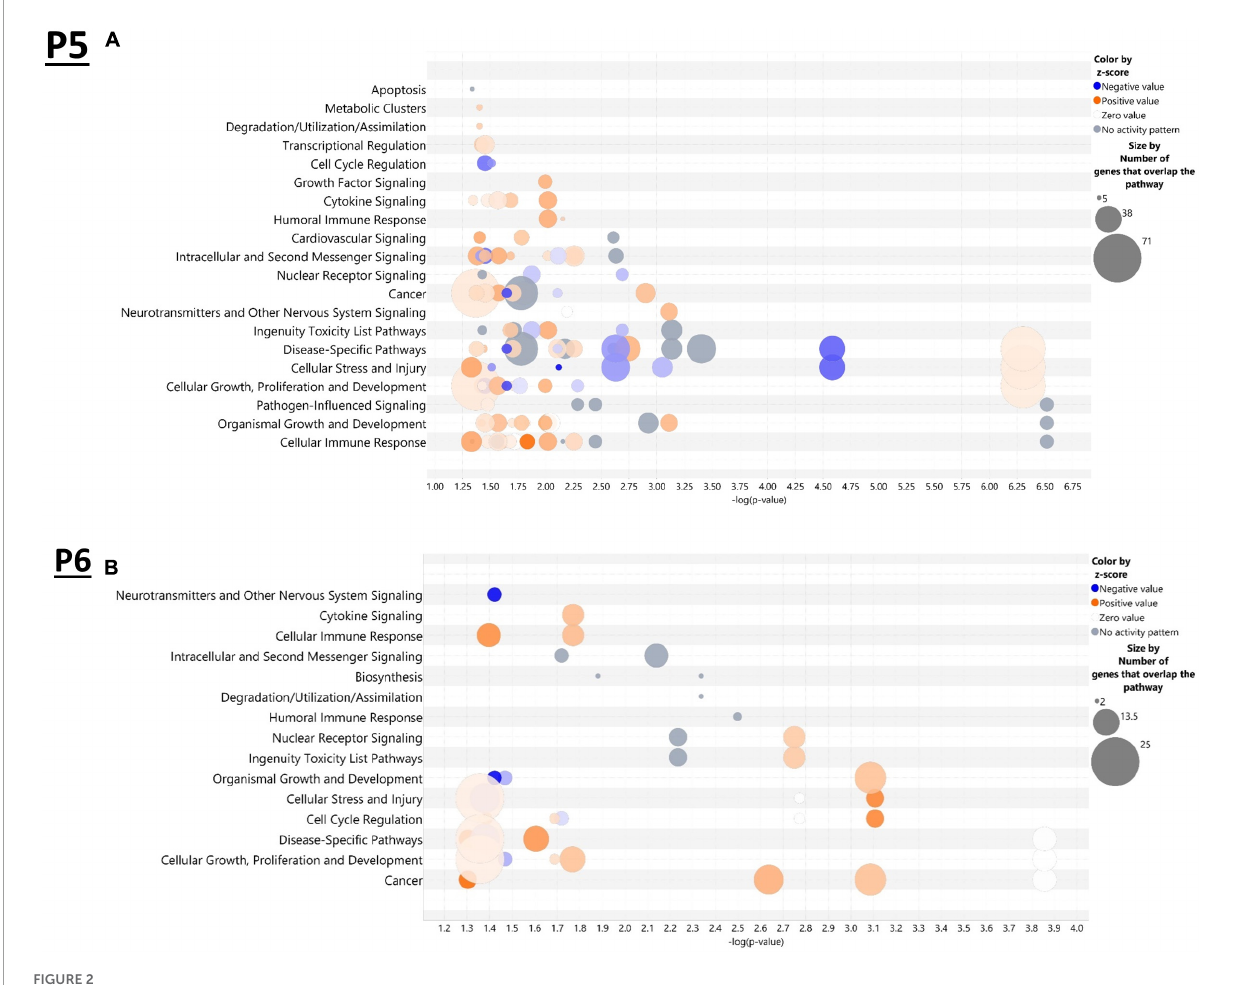
FIGURE2 Top canonical pathways altered in the brain by ethanol exposure at P5 and P6. Qiagen Ingenuity Pathway Analysis (IPA) software was employed to assess the top canonical pathways altered by ethanol at P5 (A) and P6 (B) . All analyses were restricted to genes with an adj. p < 0.05 and analysis settings were set to “brain” in IPA. n = 3 males and 3 females per treatment group E or